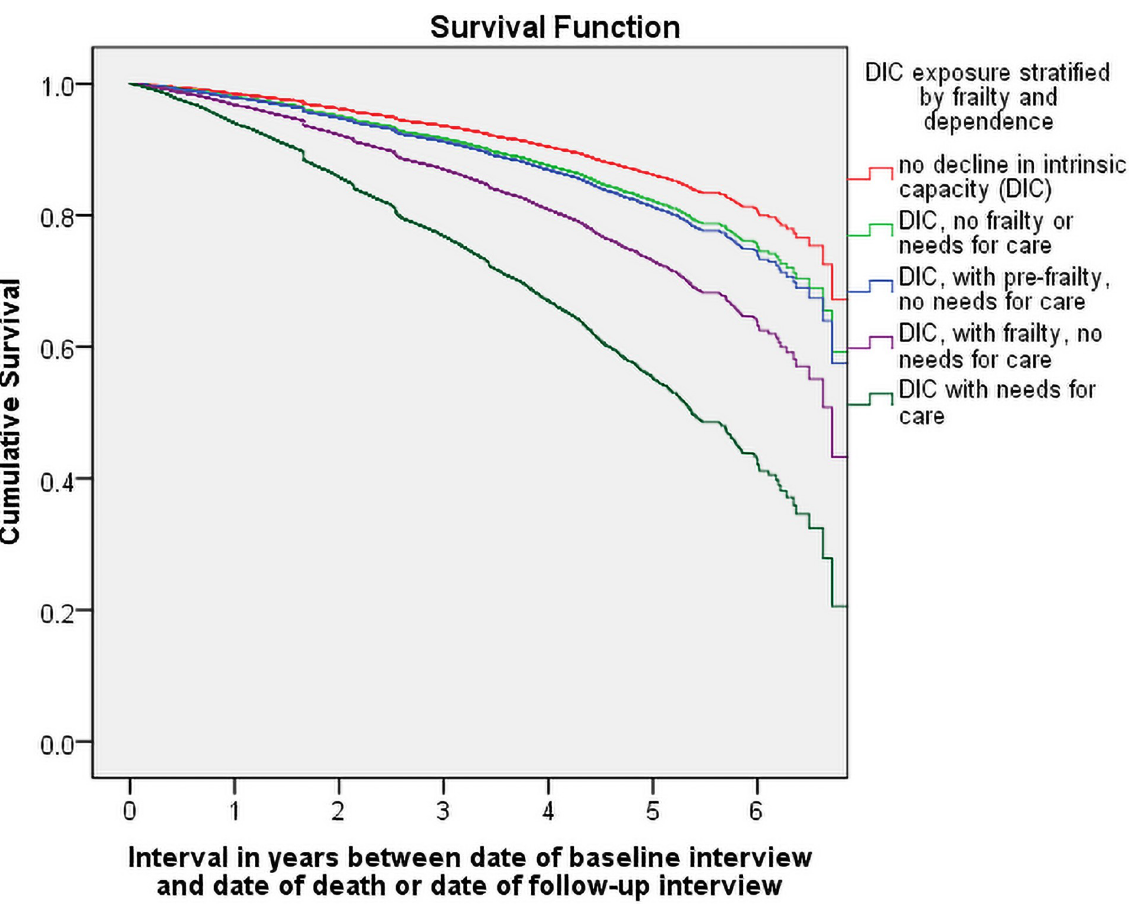
Fig 3. Cumulative survival probability by intrinsic capacity, frailty, and need for